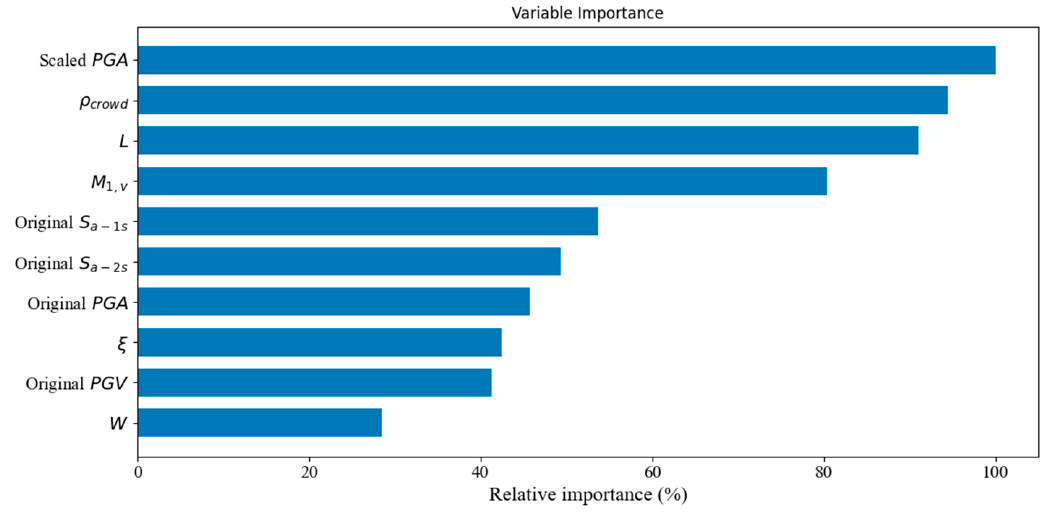
Figure 18. Relative importance of all features (input variables). 6. Vibration Serviceability Evaluation For the case with earthquake intensity 7, the results are presented in Figure 15. It can be concluded from the empirical cumulative distribution function plot (Figure 15) that when the structure is only subjected to vertical ground motions, there is approximately 50% probability that the vibration levels fall into the range of the minimum comfort limits of 1.0–2.5 m/s 2 according to Setra and HiVoSS, with the probability of the vibration levels exceeding the human comfort limits in the vertical direction (2.5 m/s 2 ) being very low ac- cording to HiVoSS. For crowd load only, the acceleration level is always lower than the